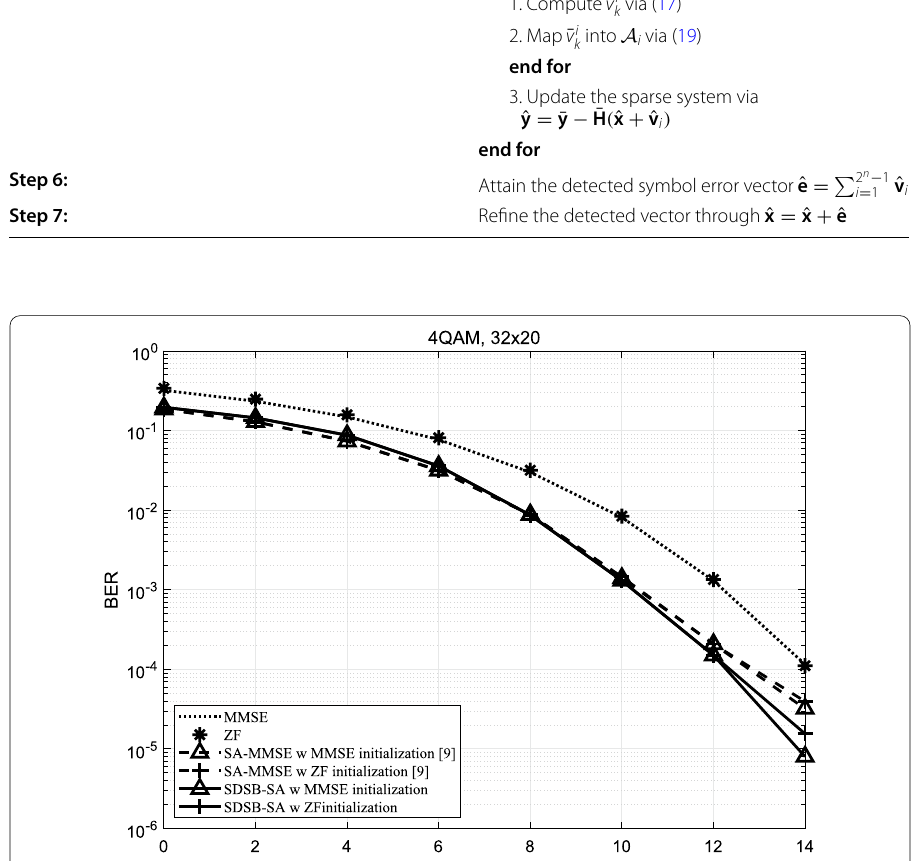
Fig. 3 Performance comparison of MMSE/ZF, MMSE/ZF system,